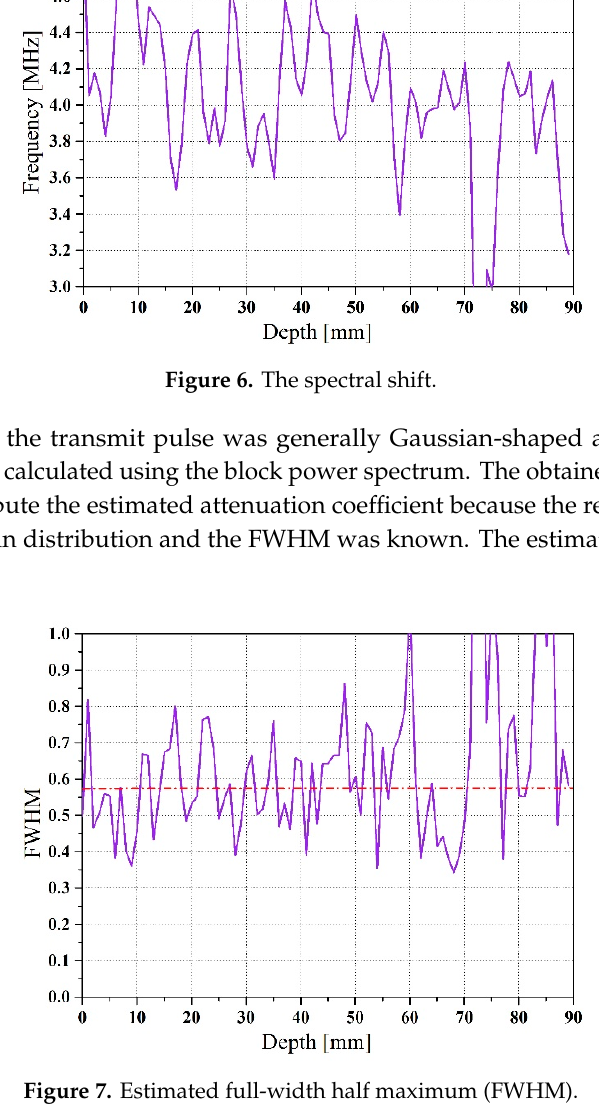
Figure 7. Estimated full-width half maximum (FWHM).